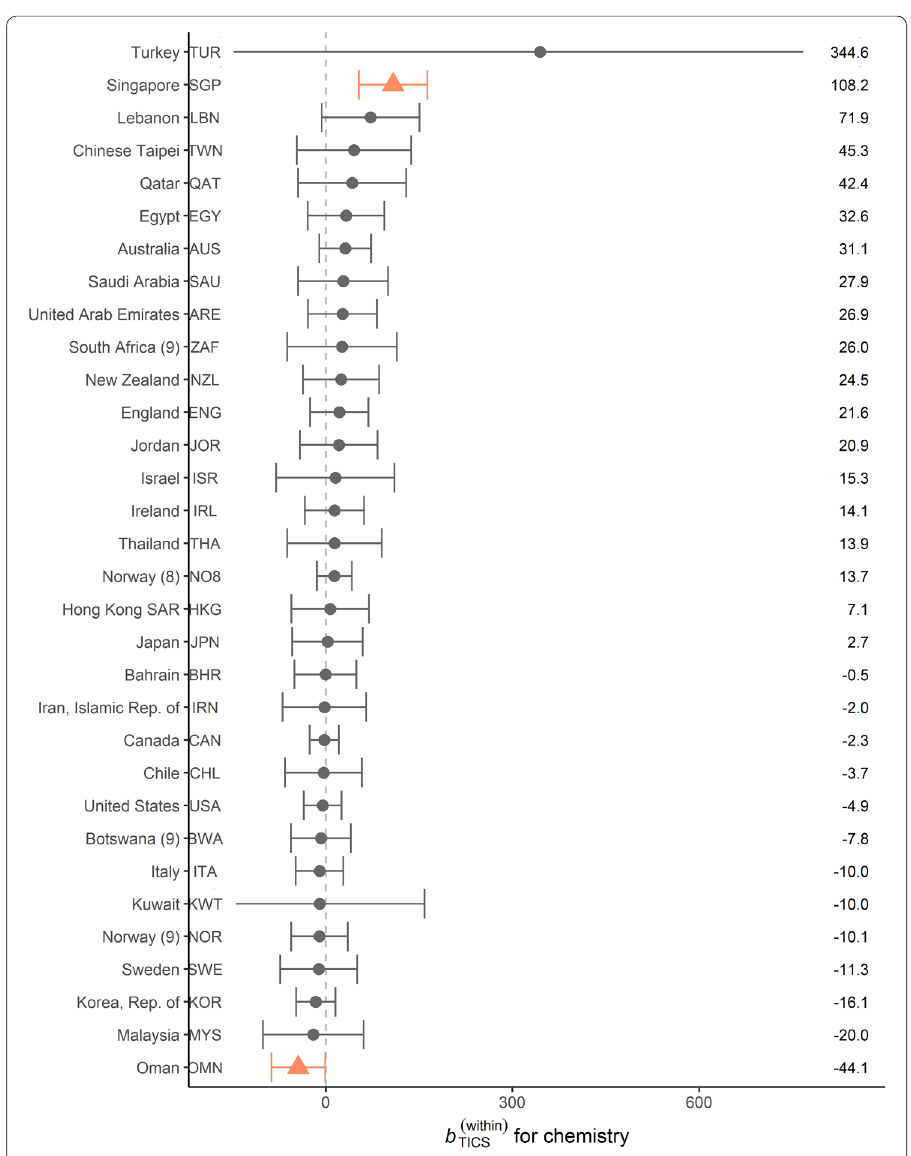
Fig. 11 Forest plot of the slope estimate in chemistry with 95% CI for TICS on achievement by